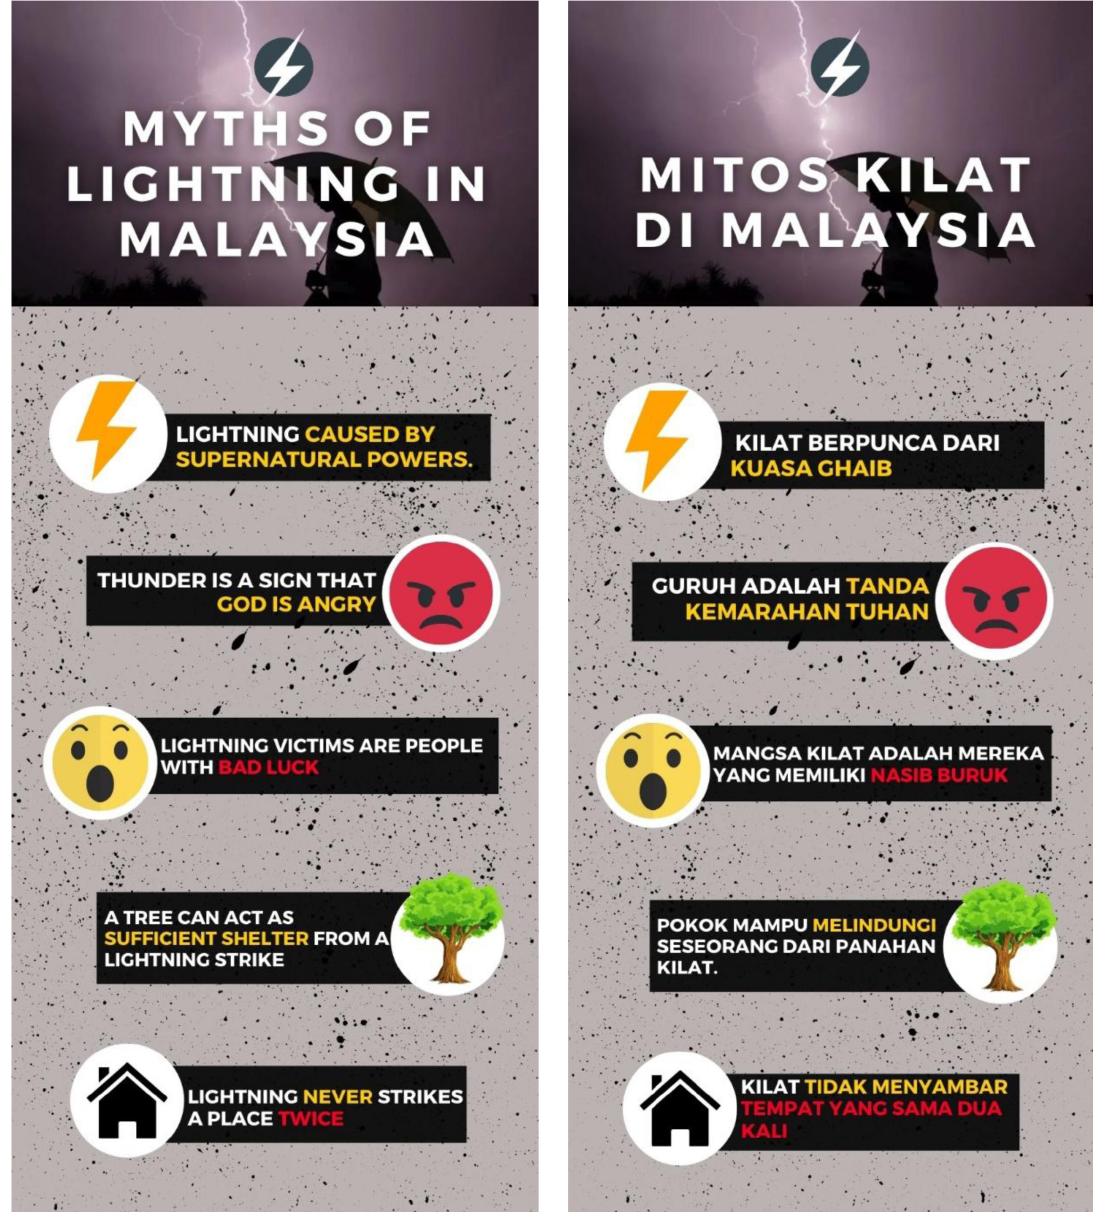
Figure 1. Common myths of lightning in Malaysia (in English and Malay).